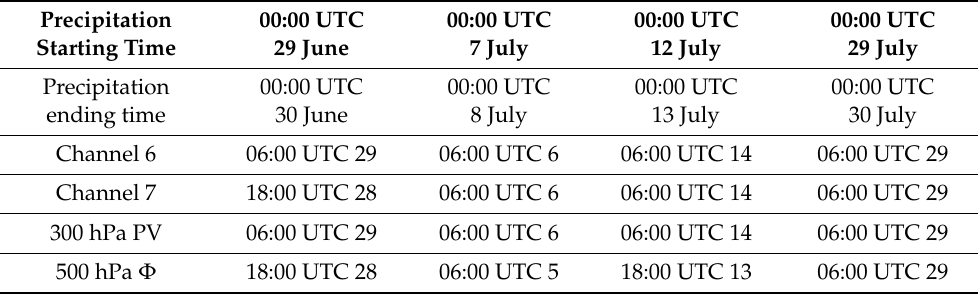
Table 3. The starting and ending times of precipitation relating to four NCCV cases in June and July 2019 and the time of cutoff low center entering the NCCV domain separately determined by MWTS-2 brightness temperature observations of channel 6 and 7, potential vorticity (PV) at 300 hPa, and geopotential height ( Φ ) at 500 hPa from the ERA5 reanalysis. The 06:00 and 18:00 UTC of channels 6 and 7 represent the ascending and descending node of the satellite observations,